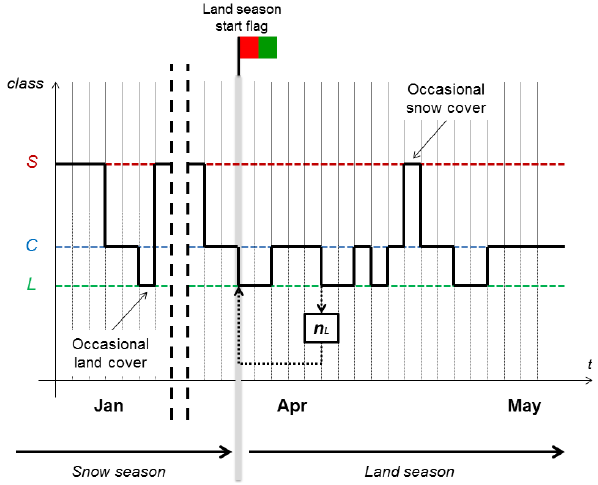
Figure 2. Criterion for identifying the start of the land season. The same rule is applied to the snow-start flag, in autumn or winter. More land/snow observations are needed in spring/autumn to split the year into two periods. The black line represents the series of observations for a reference pixel across the melting